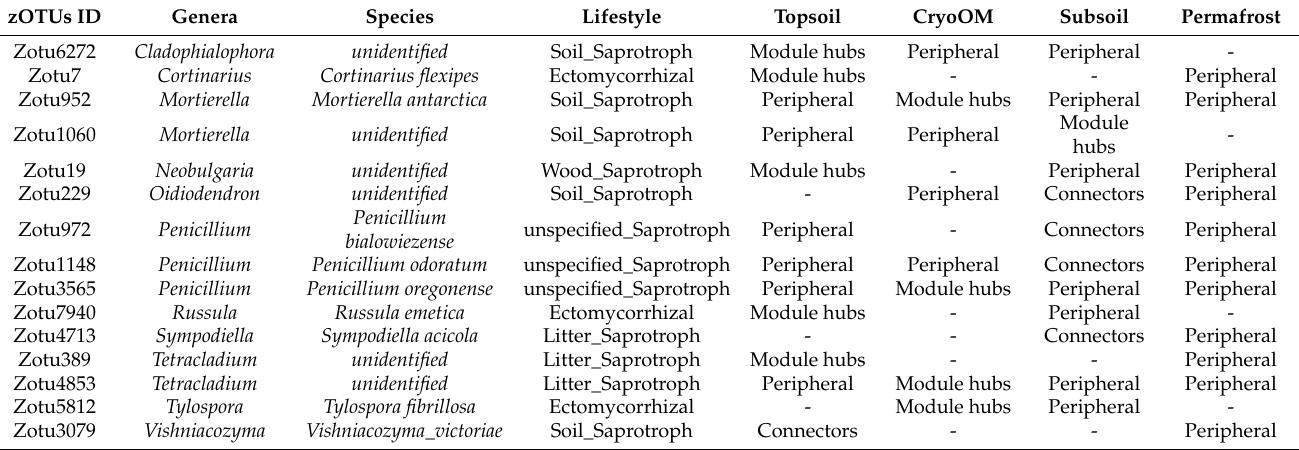
Table 3. Topological role shift between different horizons. Module hubs and connectors were considered as generalists whereas peripheral as specialists.